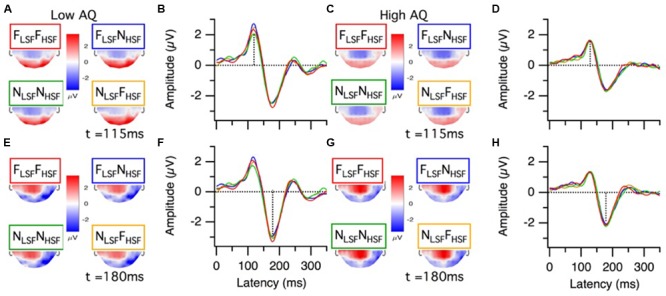
Grand average ERP results from the low and high AQ groups. P100 results for the low AQ group (n = 16) are presented as (A) topographies and (B) grand mean cluster waveforms (P8, PO8, PO7, P7, O1, O2, and Oz, cluster function = mean). Likewise, P100 results for the high AQ group (n = 17) are presented as (C) topographies and (D) grand mean cluster waveforms. N170 results for the low AQ group are presented as (E) topographies and (F) grand mean cluster waveforms (P8, PO8, PO7, P7, cluster function = mean). Likewise, N170 results for the high AQ group are presented as (G) topographies and (H) grand mean cluster waveforms. Results for the different hybrid face conditions are presented in different colors: FLSF–FHSF (red), NLSF–NHSF (green), FLSF–NHSF (blue), and NLSF–FHSF (orange). The top halves of the topography traces are occluded because we only recorded from a posterior set of electrodes (see Materials and Methods).